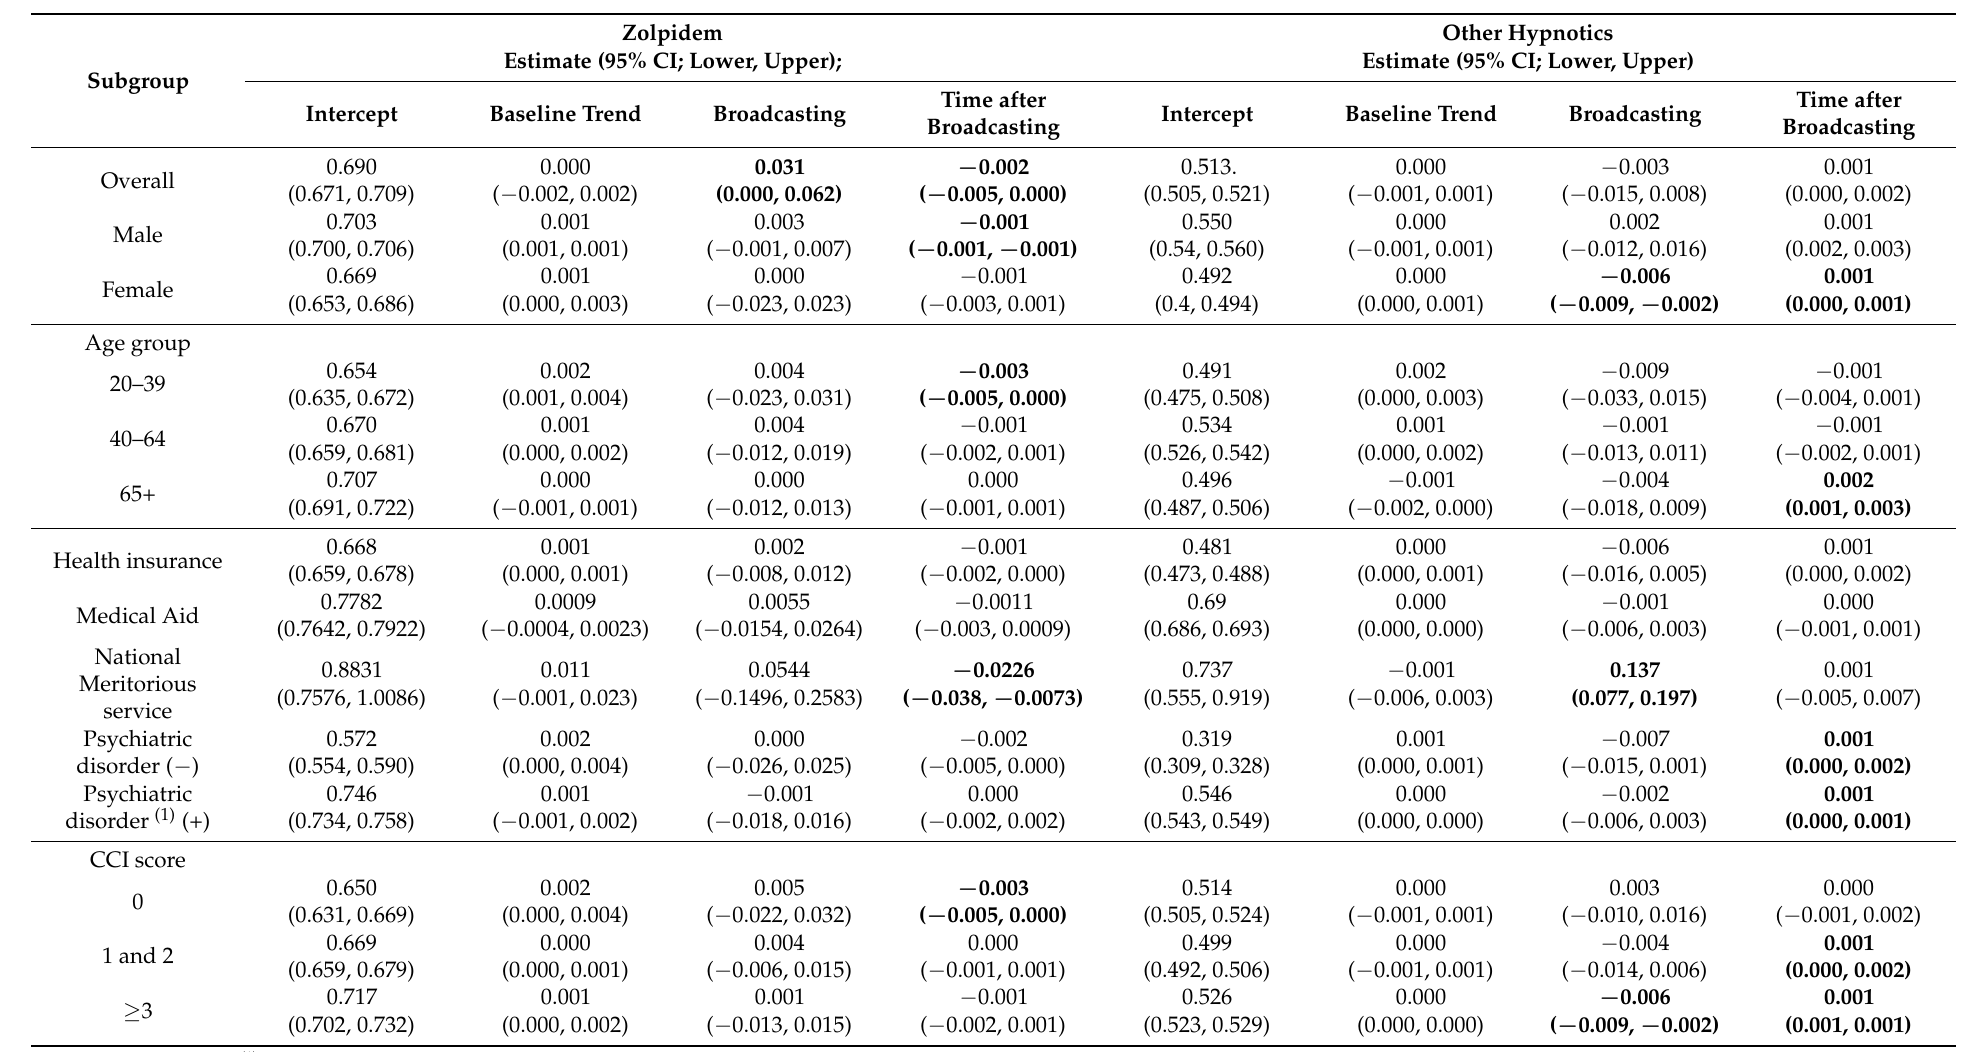
Table 3. Subgroup analysis for showing changes in the prescription rate before and after broadcasting. (unit: daily DDD/patient,